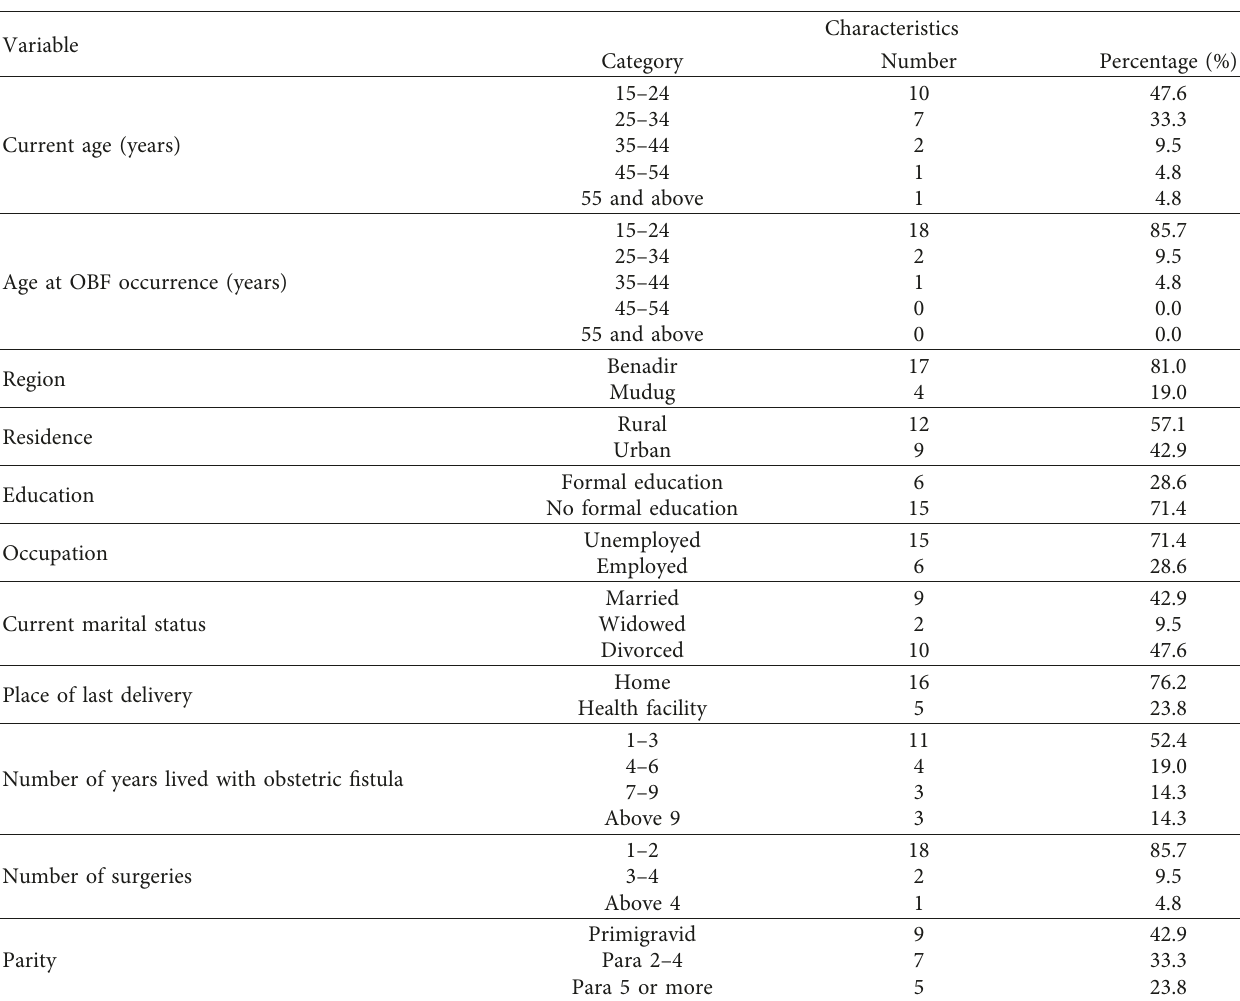
Table 1: Participants’ background